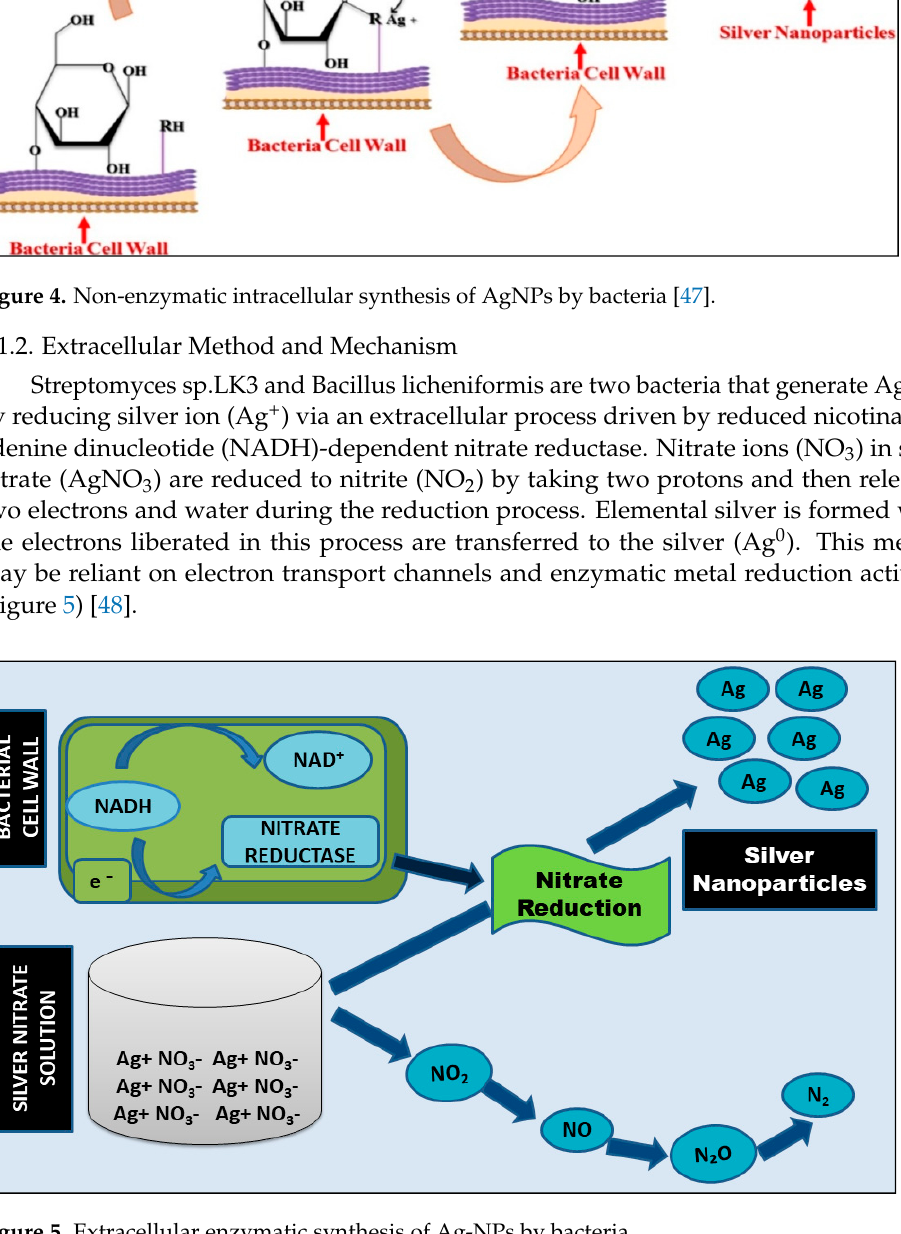
Figure 5. Extracellular enzymatic synthesis of Ag-NPs by bacteria.